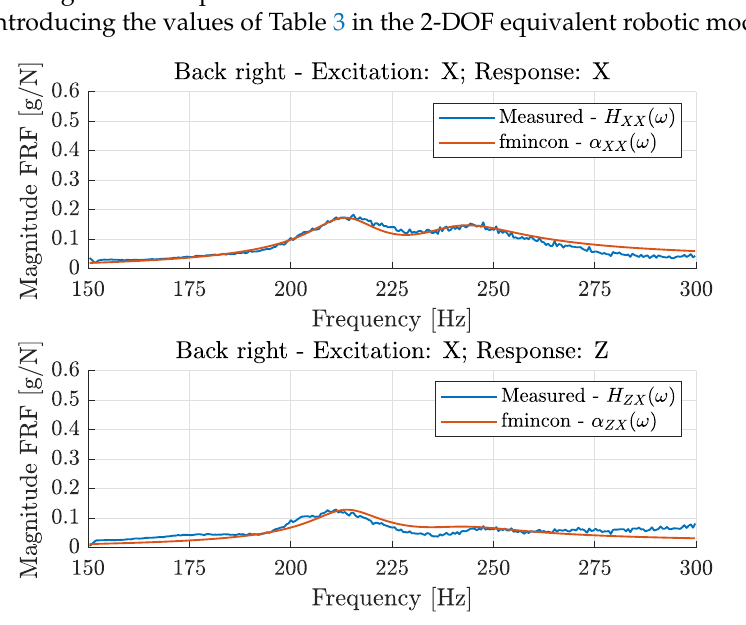
Figure 15. Comparison between the measured FRFs with the FRFs resulting from the optimization algorithm fmincon